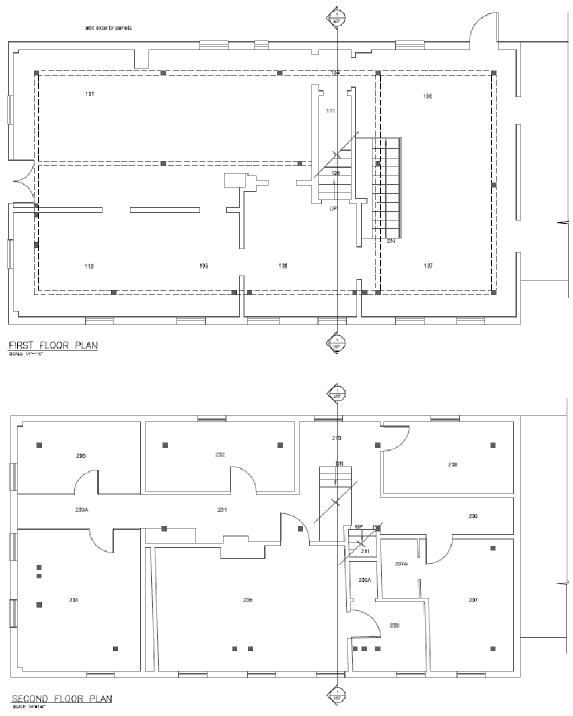
Figure 4: Sinclair Inn Museum Ground and Second Floor Plans showing reinforcing structural upgrades. Plans Prepared by Jost Architects Ltd.